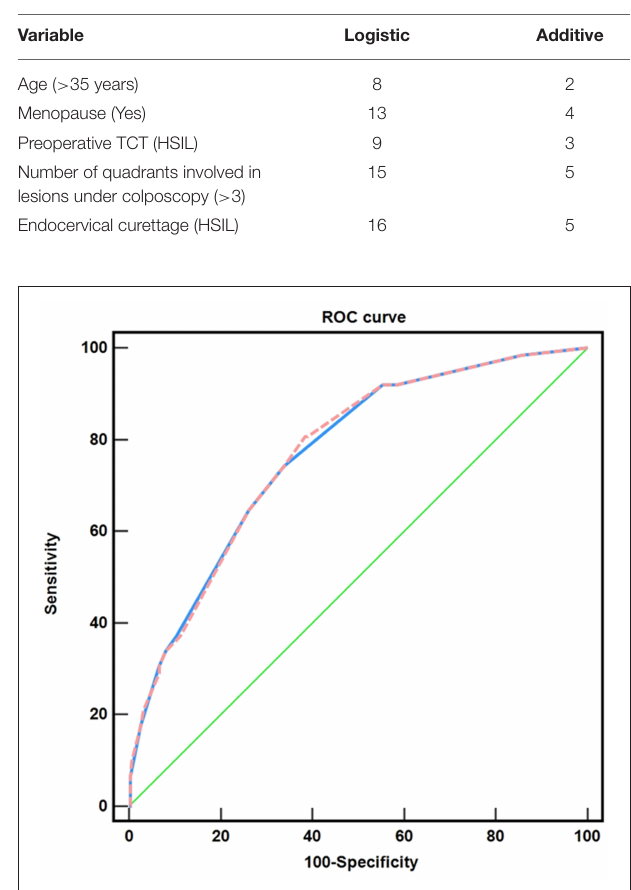
FIGURE 3 | Comparison of the two risk scoring systems. ( ) the logistic scoring system, AUC: 0.769; ( ) the additive scoring system, AUC: 0.768; ( ) reference